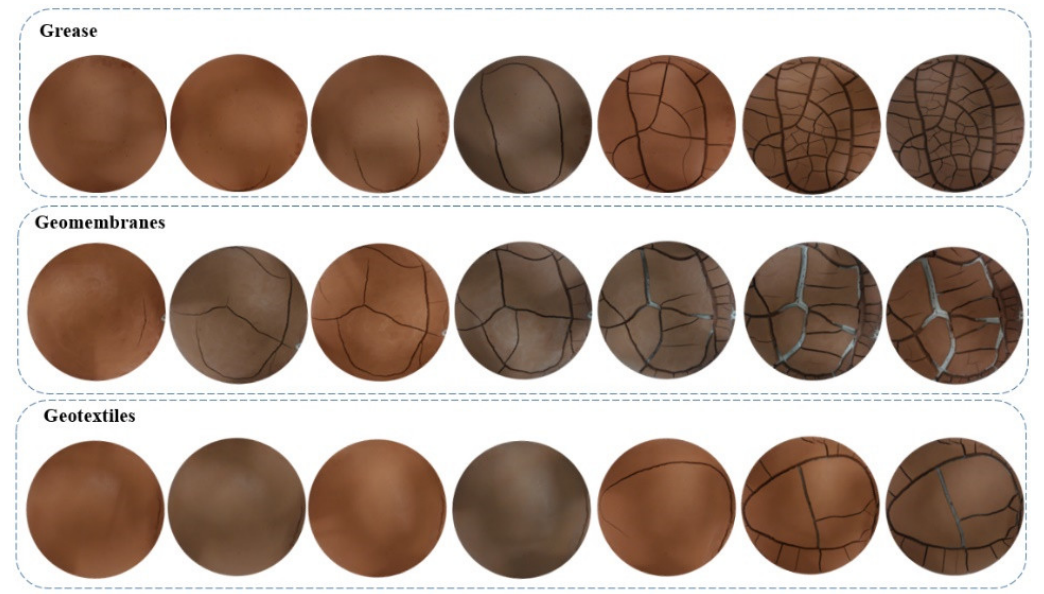
Figure 2. Development process of cracks in samples.